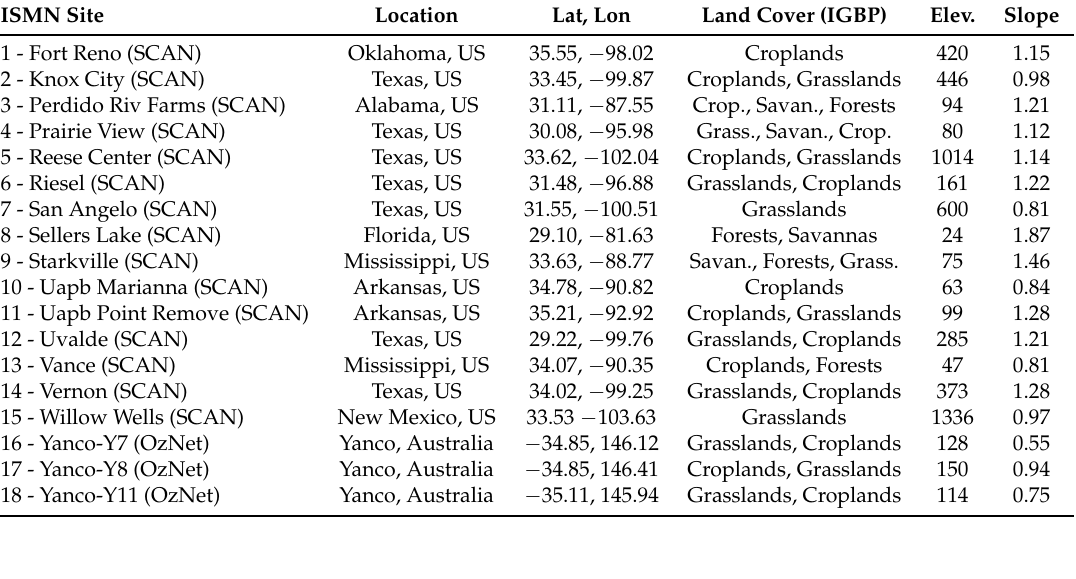
Table 2. Soil moisture sites that are analyzed in this study. Elevation (in meters) and slope values are calculated as mean values over the 9-km grid.